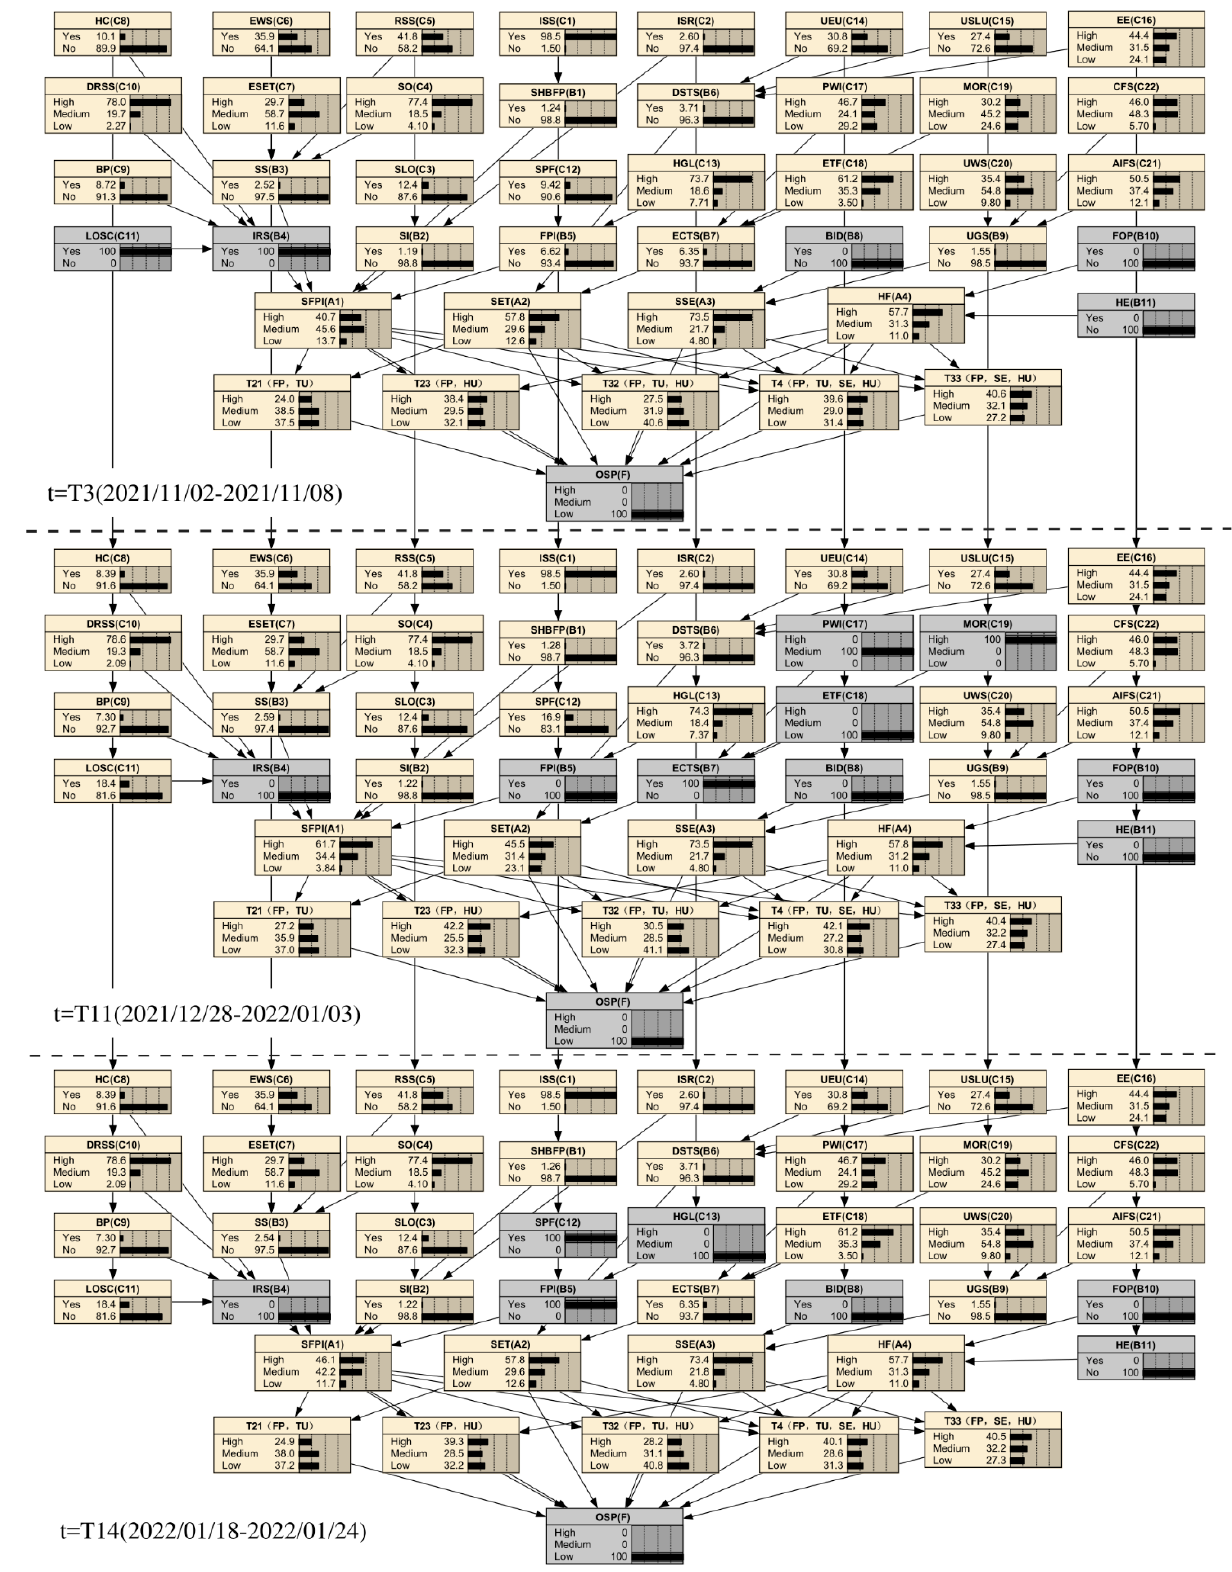
Figure 16. Three scenarios of backward inference.